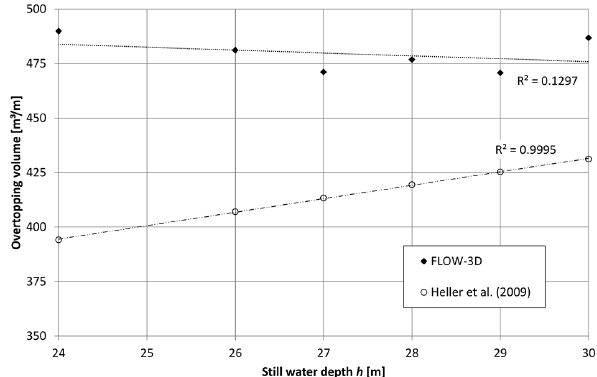
Figure 6. Overtopping volume V depending on a variation of the still water depth h including trendlines with a fixed freeboard f = 2m.